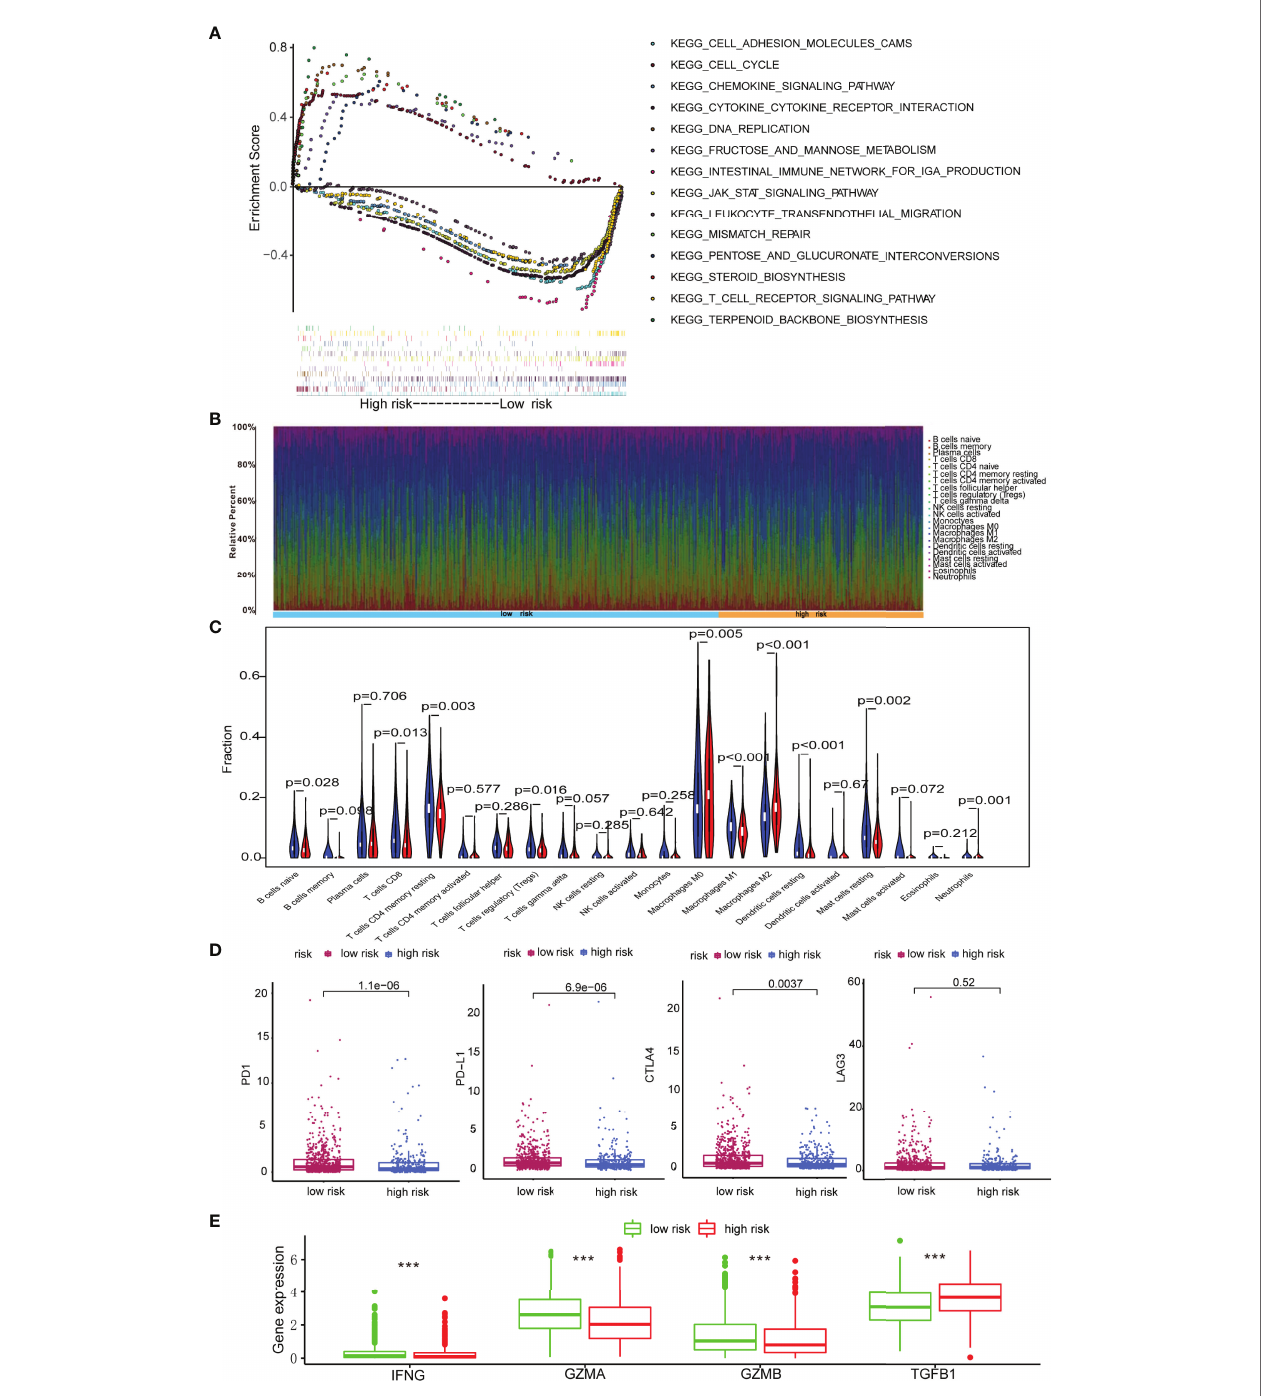
FIGURE 5 | Immune landscape in breast cancer patients with low- and high-score. (A) GSEA revealing biological processes correlated with risk model; (B) The abundances of immune cells in tumor microenvironment; (C) Comparison of proportion of immune cells types in patients with low- and high-score; (D) Immune checkpoints including PD1, PD-L1, CTLA4, and LAG3 expression in patients with low-score and high-score. (E) Expression levels of IFNG, GZMA, GZMB and TGFB1 in patients with low-score and high-score. ***p <